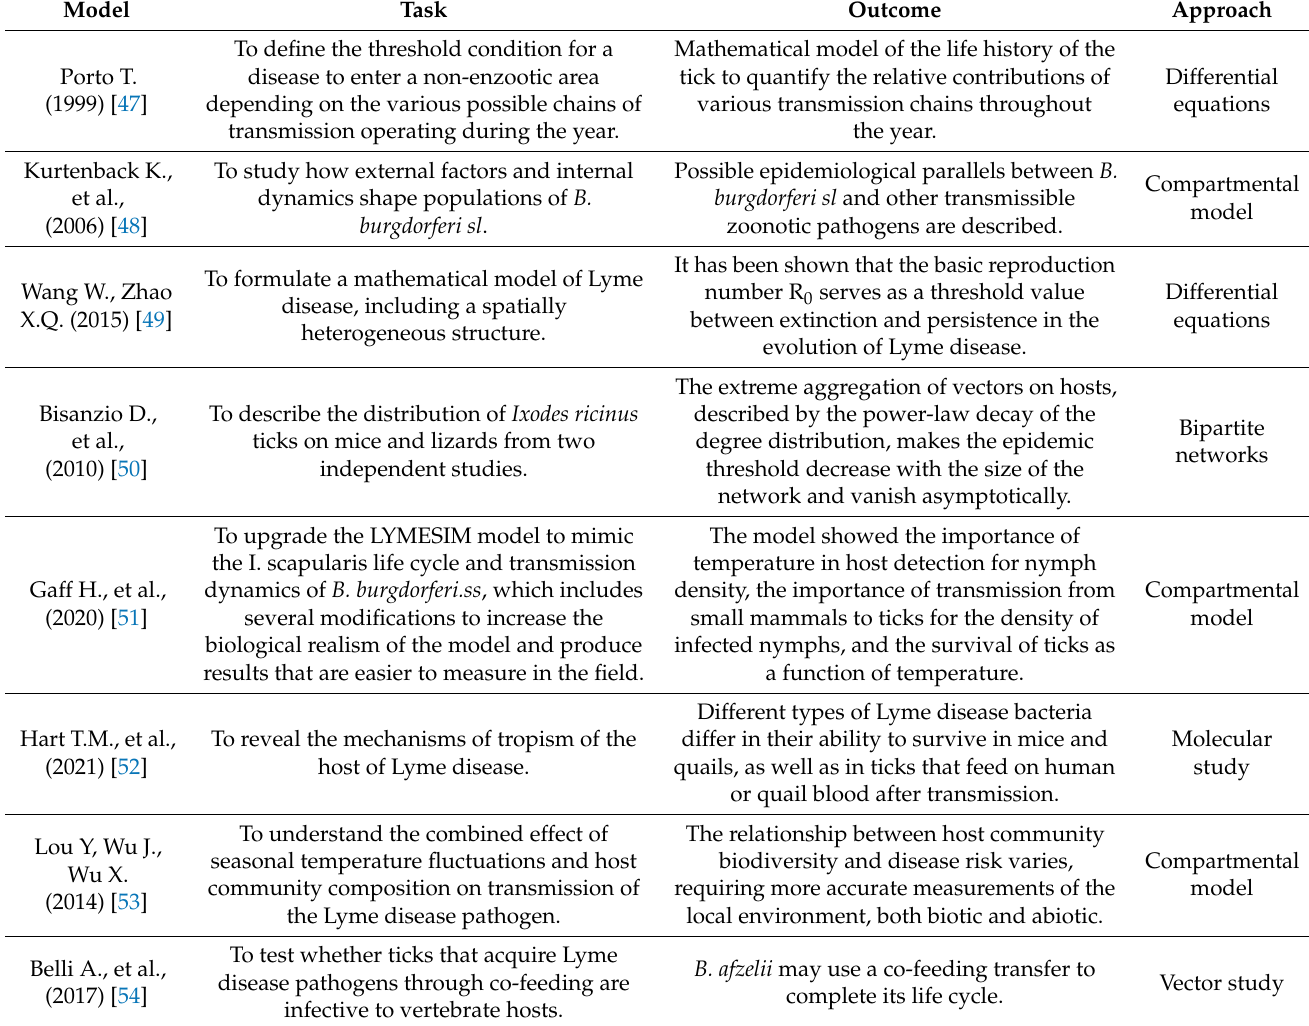
Table A1. Current state of Lyme disease